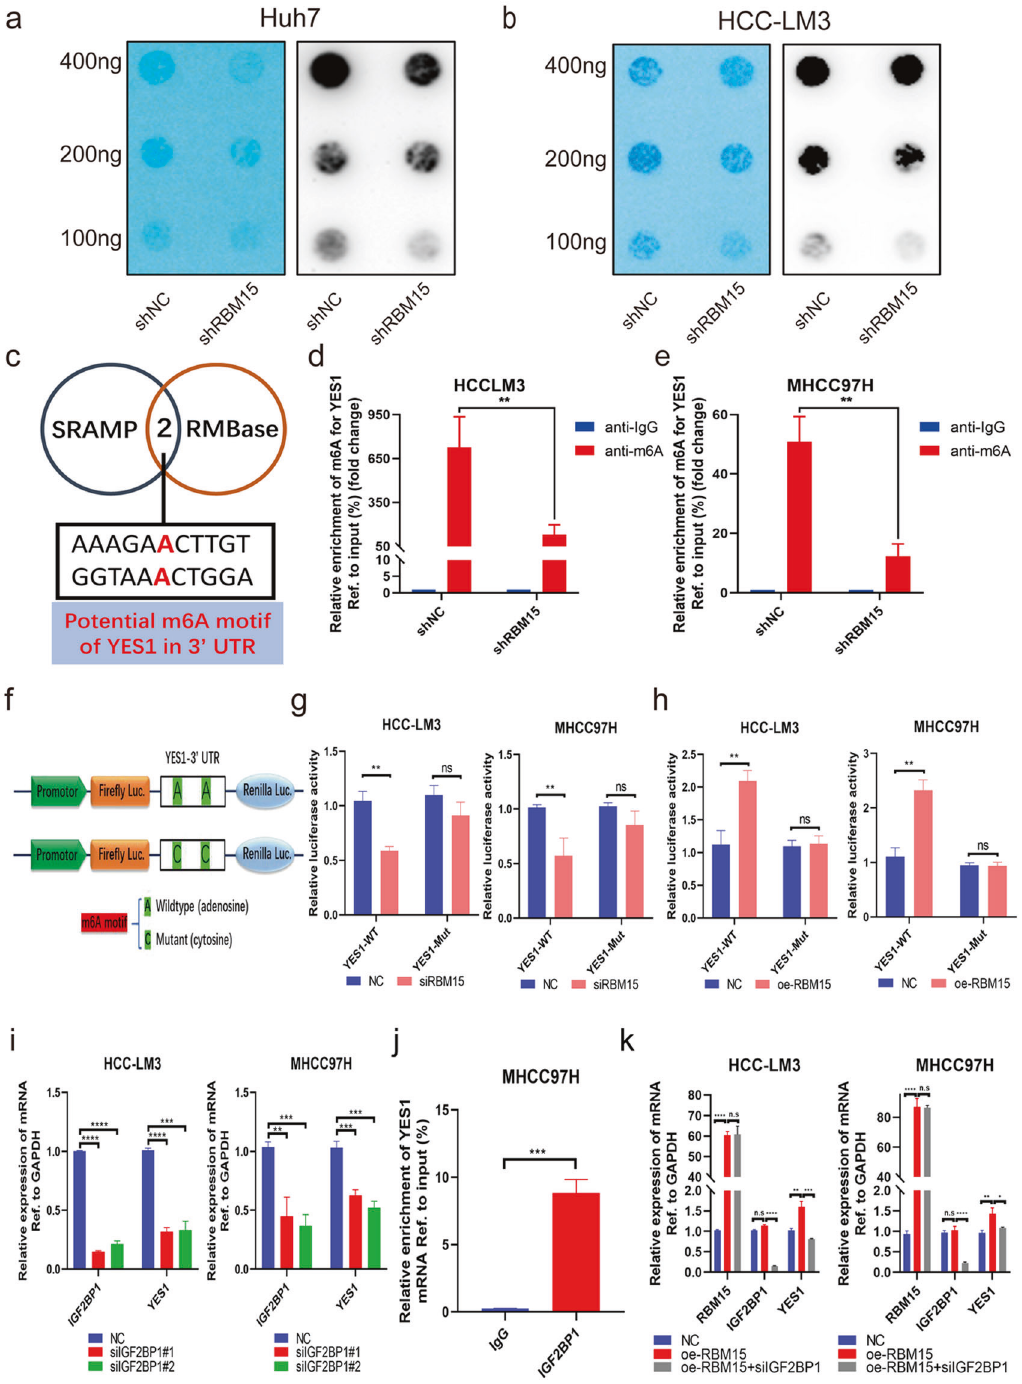
Fig. 5 RBM15 regulates YES1 in an IGF2BP1-m 6 A-dependent pattern. a , b Global m 6 A level of RNA extracted from RBM15-knockdown Huh7 and HCC-LM3 cells was investigated by m 6 A dot blot assays. The intensity of dot immunoblotting indicated the m 6 A level of total RNAs, while methylene blue staining was applied to measured input RNA; c a Venn diagram was generated for predicting potential m 6 A motif of YES1 in 3 ’ UTR from SRAMP and RMBase databases. Two candidate m 6 A motifs were selected; d , e showed m 6 A modi fi cation of YES1 by MeRIP-qPCR analyses in HCC-LM3 and MHCC97H cells. Knockdown of RBM15 induced a decreased m 6 A abundance on YES1 compared with the control group (** p < 0.01; t test); f construction pattern of luciferase reporters. The wild-type or mutant type (m 6 A motif mutated) sequence of YES1 3 ’ UTR was inserted into a pcDNA 3.1 vector, which contained Fire fl y and Renilla elements; g relative luciferase activity of the wild-type or mutant group was determined in RBM15-silenced HCC-LM3 and MHCC97H cells (normalized to Renilla activity; ** p < 0.01; t test); h relative luciferase activity of the wild-type or mutant group was determined in RBM15 overexpression HCC-LM3 and MHCC97H cells (normalized to Renilla activity; ** p < 0.01; t test); i YES1 mRNA expression was decreased after knockdown of IGF2BP1 in HCC-LM3 and MHCC97H cells (** p < 0.01, *** p < 0.001, **** p < 0.0001; t test). j RIP-qPCR validated that YES1 mRNA could bind to IGF2BP1 protein (*** p < 0.001; t test); k the upregulation YES1 mRNA induced by RBM15 overexpression was reduced by knockdown of IGF2BP1 (* p < 0.05, ** p < 0.01, *** p < 0.001, **** p < 0.0001; t test). The data are presented as mean ±